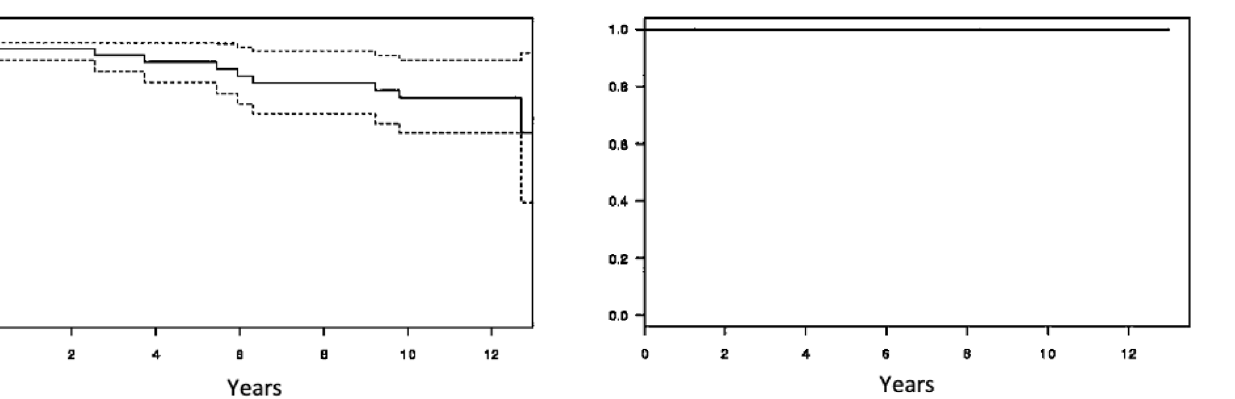
Figure 2. Survivorship of implants with revision surgery for any reason using Kaplan-Meier.